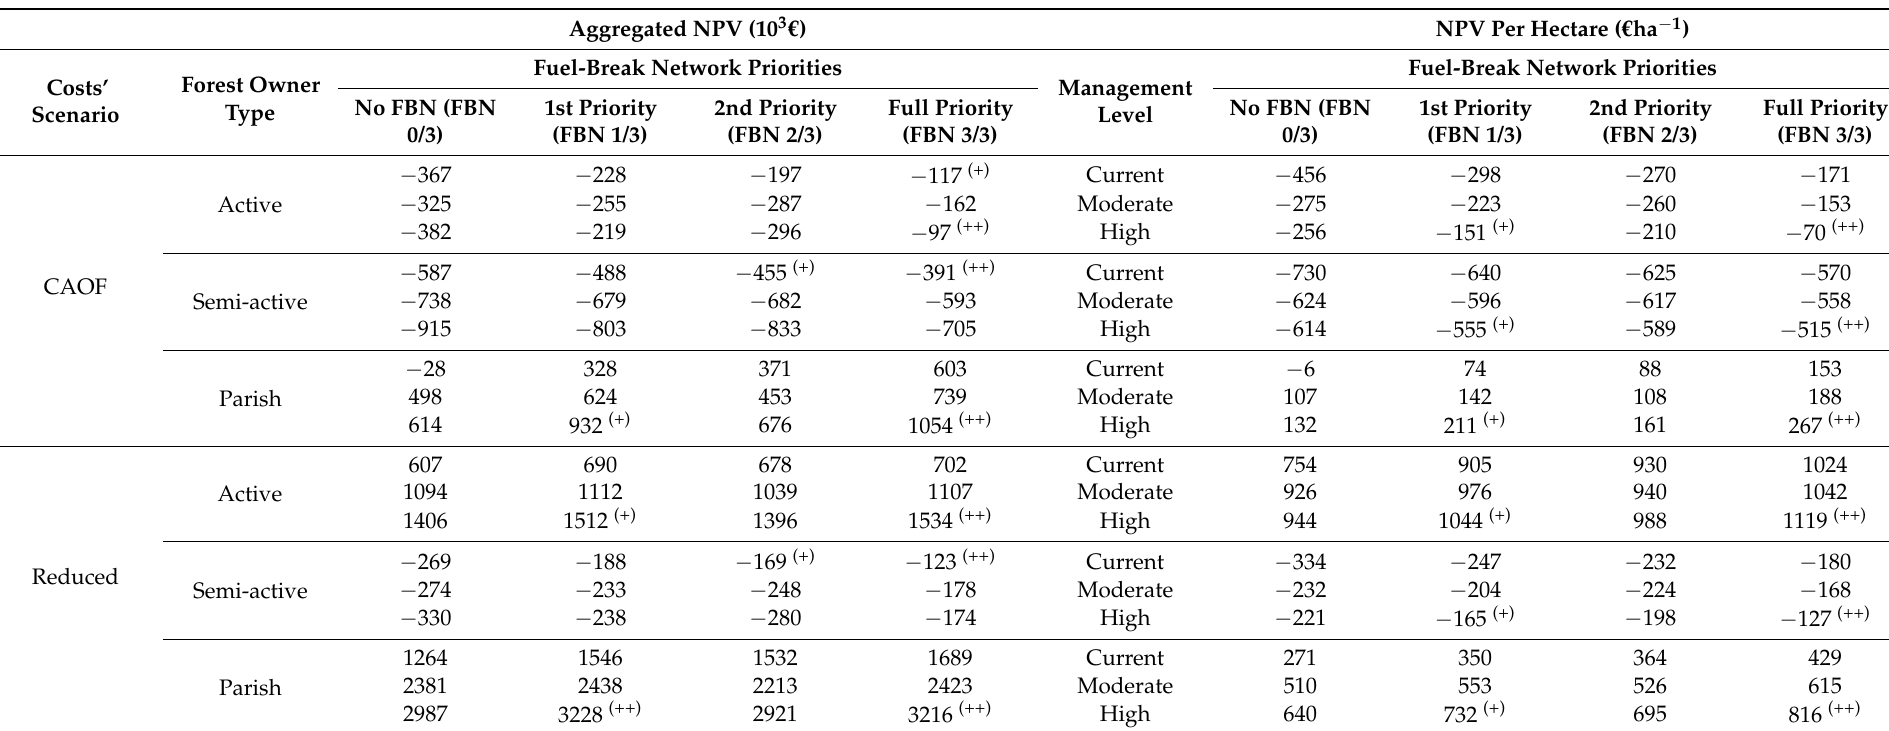
Table A4. Aggregated and per ha net present value (NPV) for all the fire scenarios for Active, Semi-active and parish under CAOF and reduced costs; the best and second best scenarios by owner type/parish are marked with (++) and (+),